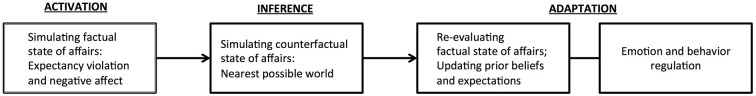
Stages of counterfactual reasoning: a schematic overview.